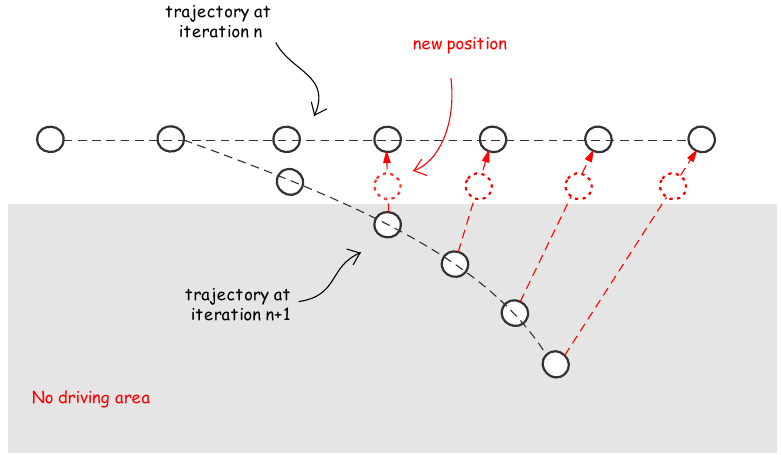
Figure 10. New trajectory in non-driving area The final trajectory is then selected and sent to the vehicle controller. At the next iteration, the exploring trajectory starts at the new position of the vehicle, and uses the last n − 1 points of the final trajectory; one last point is added assuming constant speed and steering. The environment data is updated (obstacle positions and speeds, road,